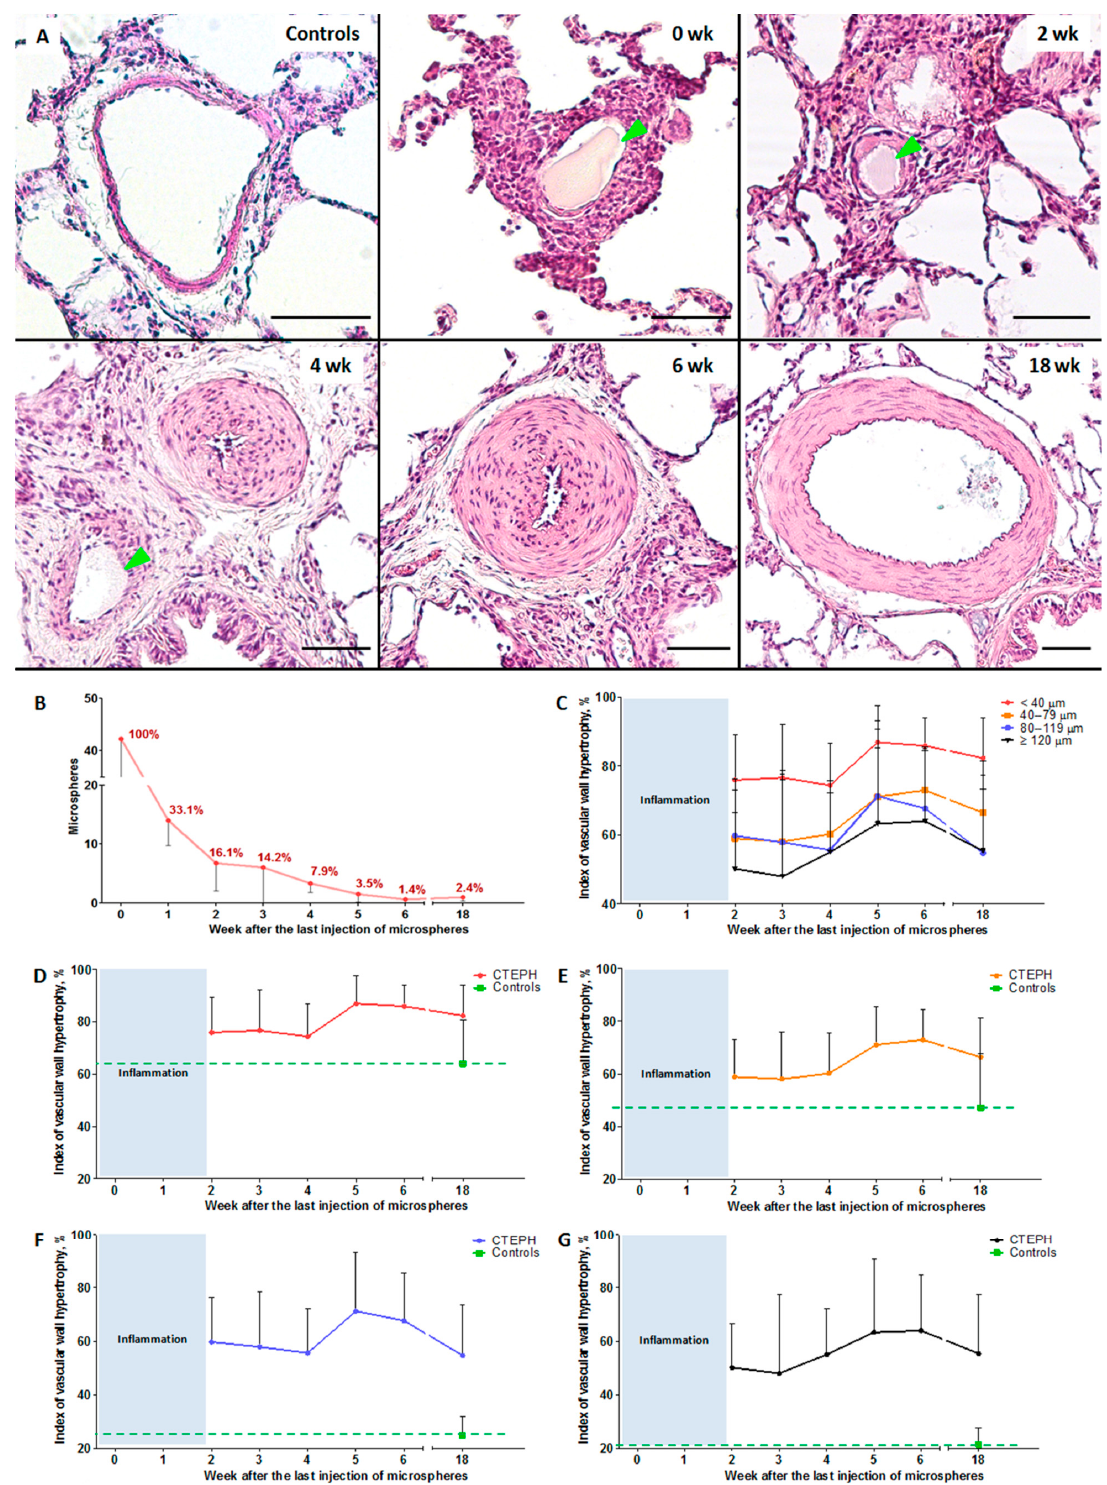
Figure 3. Histological examination of the lung vessels. ( A ) Representative microphotographs of the branches of the pulmonary artery at different periods of observation after embolization, staining: hematoxylin–eosin, scale bar: 50 µ m, green arrows indicate microspheres in the lumen of the vessels. ( B ) Biodegradation of microspheres in the vascular bed. ( C – G ) Index of hypertrophy of the vascular wall of the pulmonary artery branches. ( C ) For all diameters of vessels. ( D ) For vessels with an outer diameter <40 µ m. ( E ) For vessels with a diameter of 40–79 µ m. ( F ) For vessels with a diameter of 80–119 µ m. ( G ) For vessels with a diameter ≥ 120 µ m. n = 7 at each time point in CTEPH